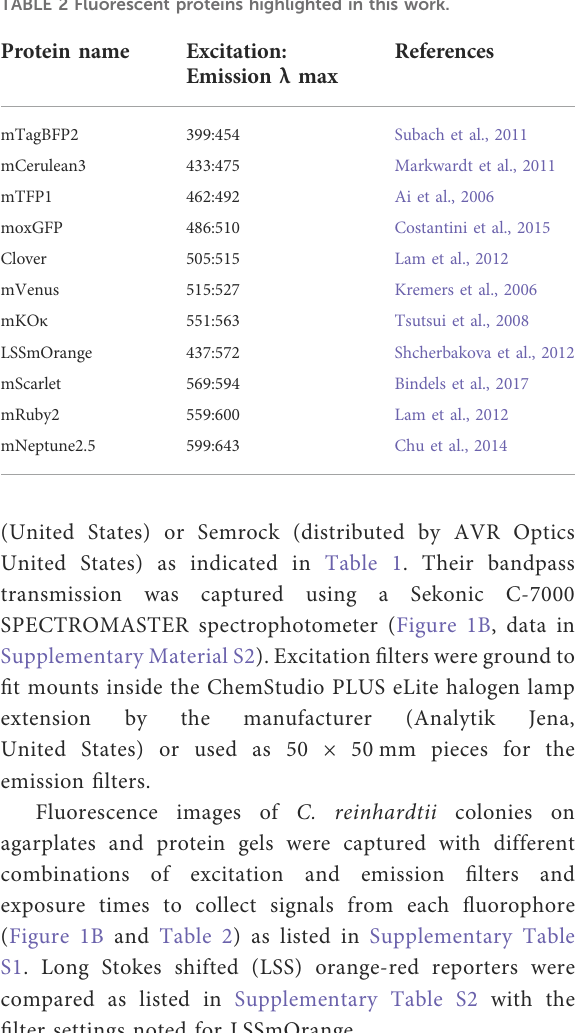
TABLE 2 Fluorescent proteins highlighted in this